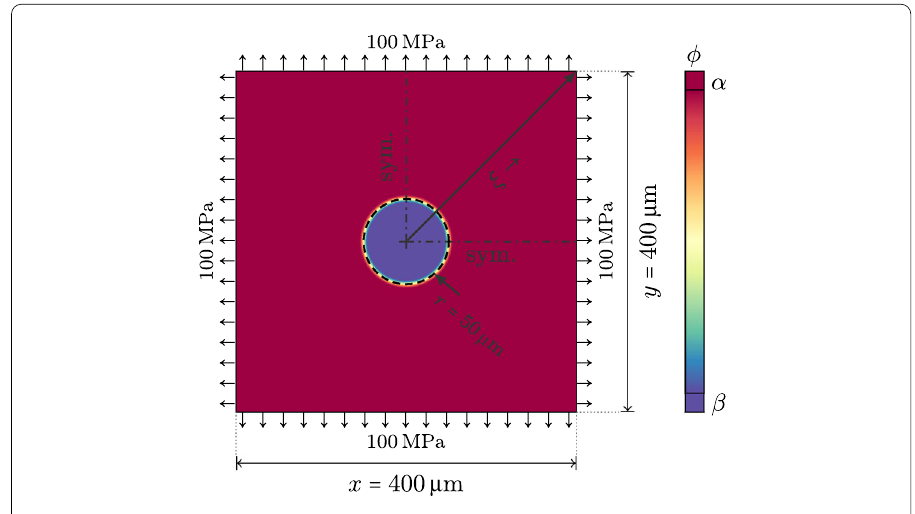
Fig. 11 Setup: Two linear visco-elastic phases, where an α -phase surrounds a β -phase inclusion